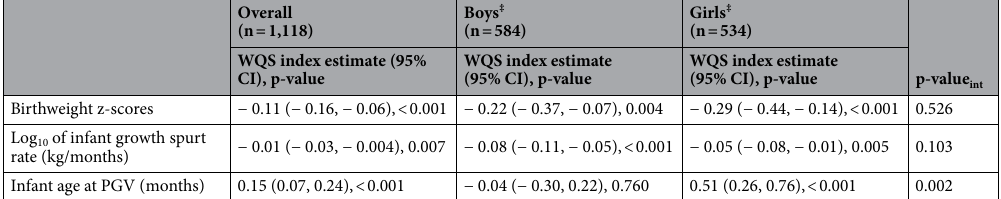
Table 3. Adjusted associations † from the WQS linear regression between prenatal EDC mixture and children´s growth characteristics, overall and by sex, n = 1,118. Abbreviations: PGV = Peak growth velocity. † Adjusted for maternal age, BMI, education, smoking, parity, child’s sex and gestational age at birth. Models with birthweight z-scores as outcome were not adjusted for sex or gestational age. Stratified models were not adjusted for sex. ‡ Results are derived from the stratified WQS model allowing for sex-specific weights and including the interaction term WQS*sex (p-value int